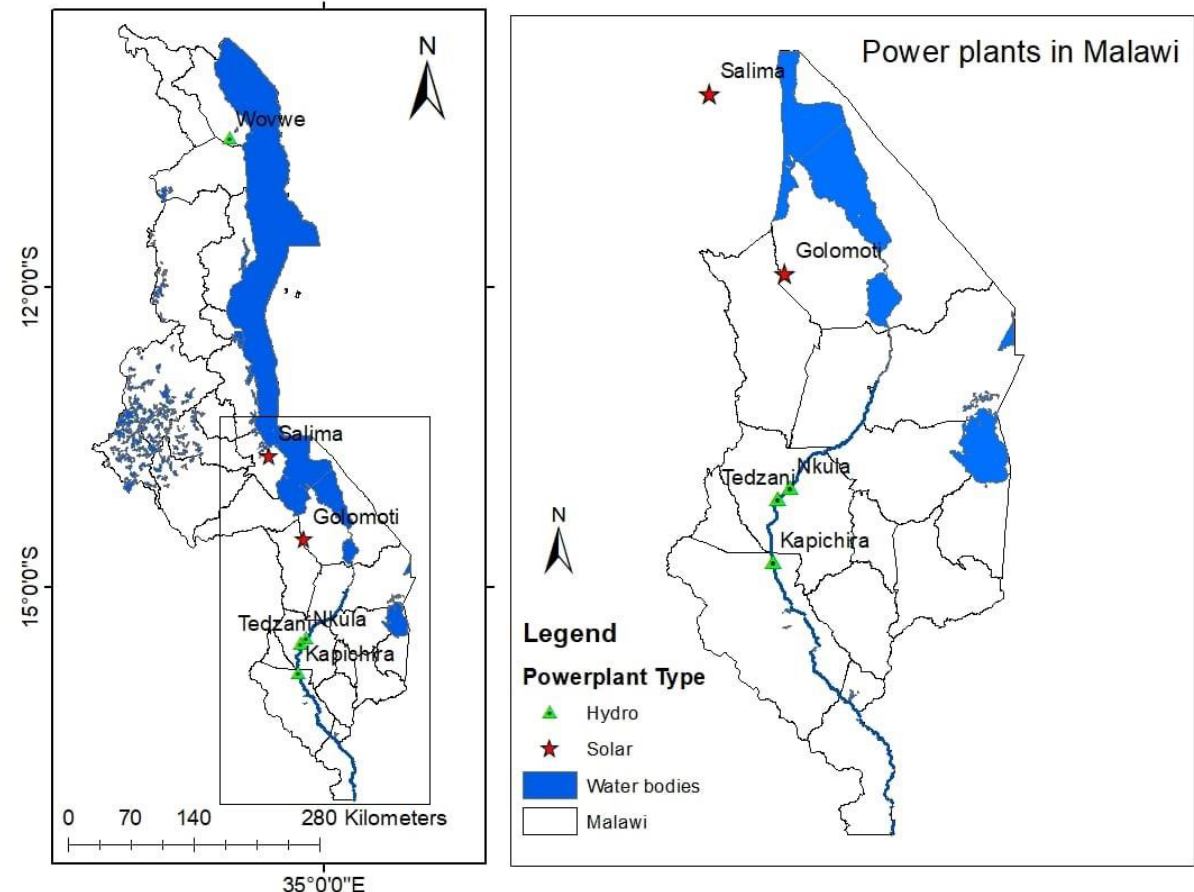
Figure 1. A map indicating the locations of power generation facilities in